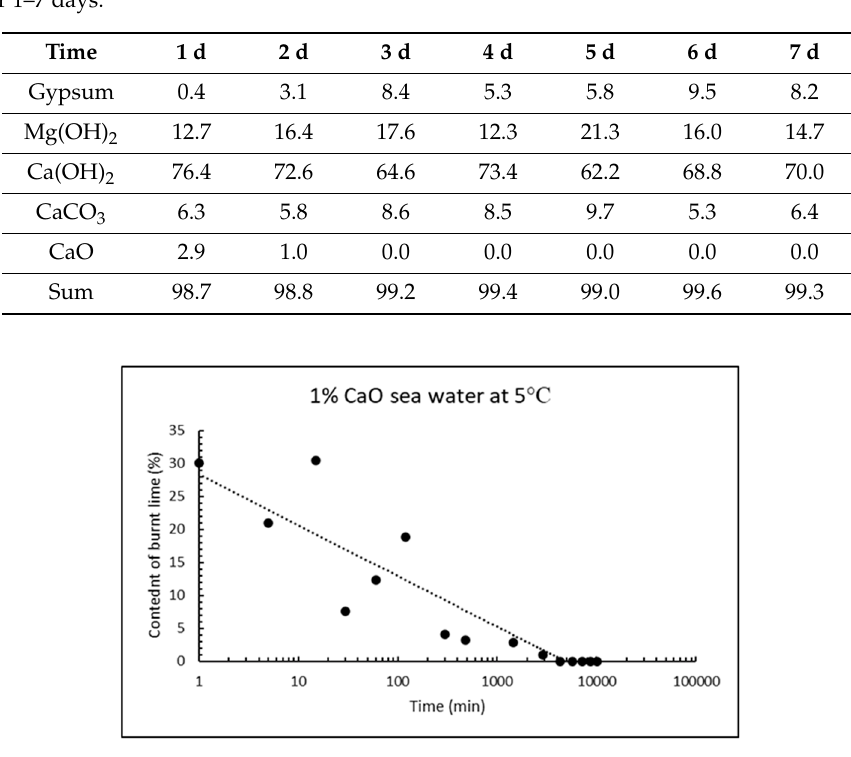
Figure 14. Remaining content of CaO as a function of time after 1% fine CaO have been mixed in sea water at 5 °C.